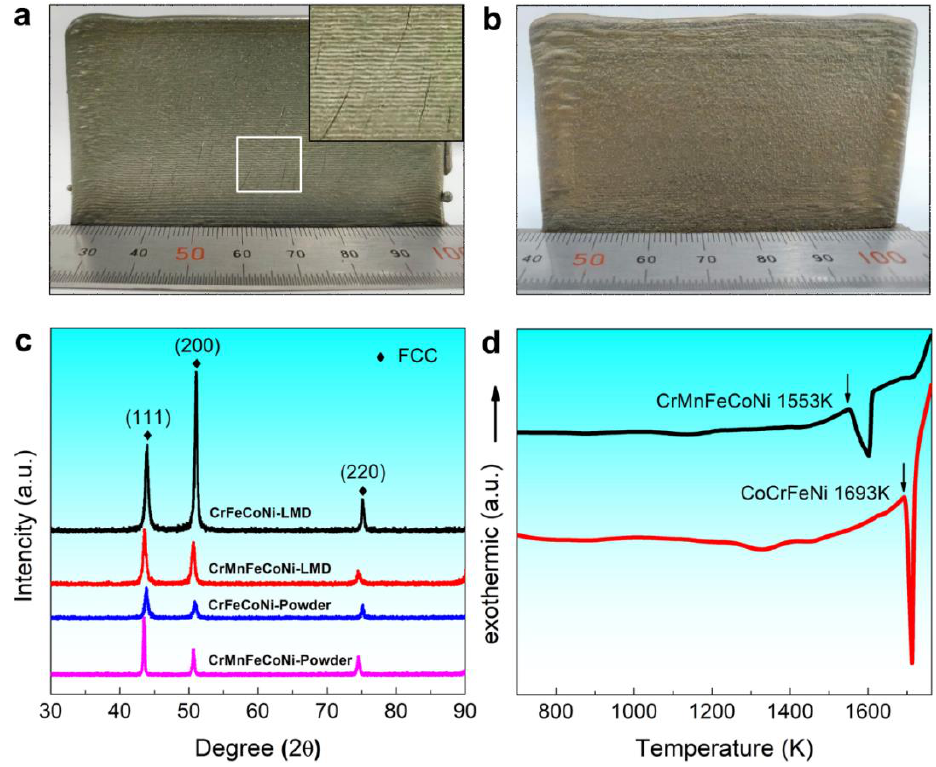
Figure 1. ( a , b ) DED-fabricated samples of CoCrFeNi and CrMnFeCoNi, respectively; ( c ) XRD spectrums and ( d ) DSC curves of the CoCrFeNi and CrMnFeCoNi MPEAs.